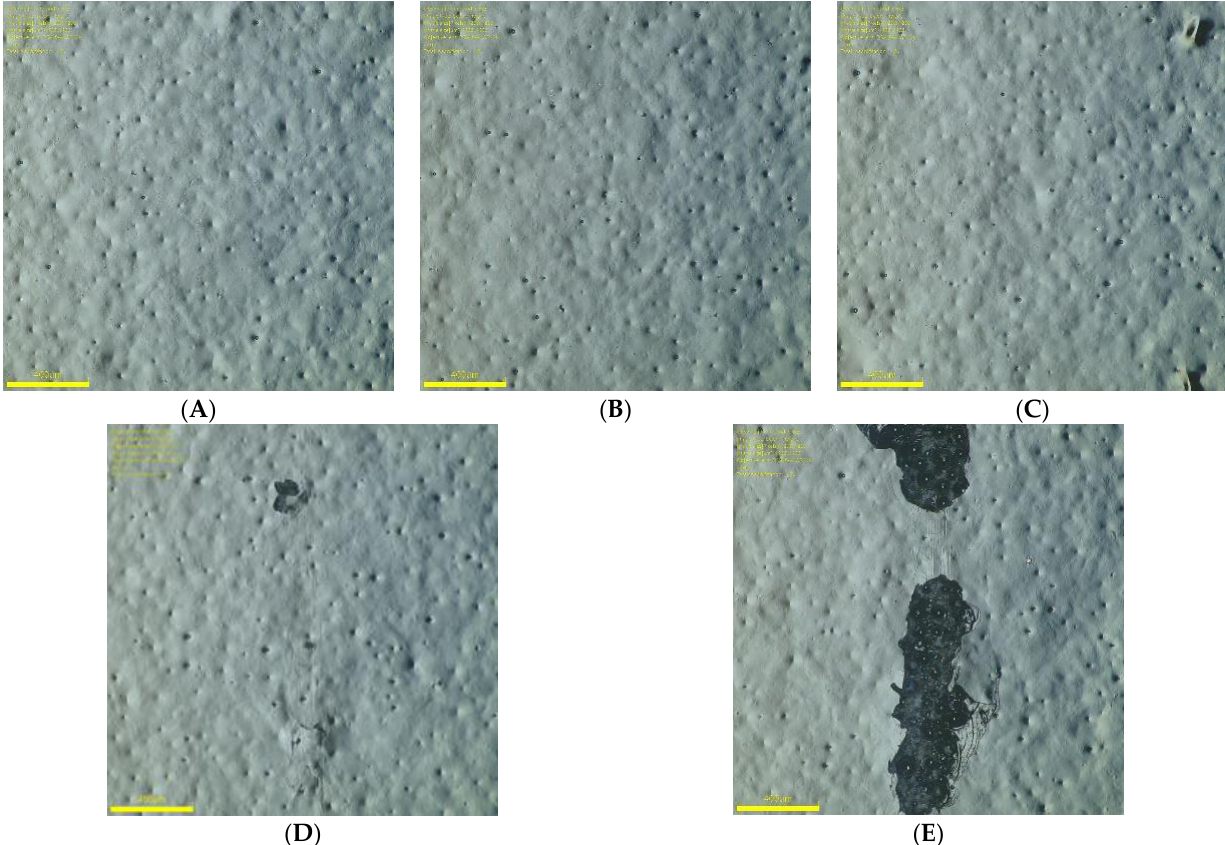
Figure 15. Surface analysis of coated samples: ( A ) without testing, ( B ) after the fire, ( C ) after NaOH immersion, ( D ) tested with 3 kg and ( E ) tested with 4 kg (magnification yellow bars are 400 μm).